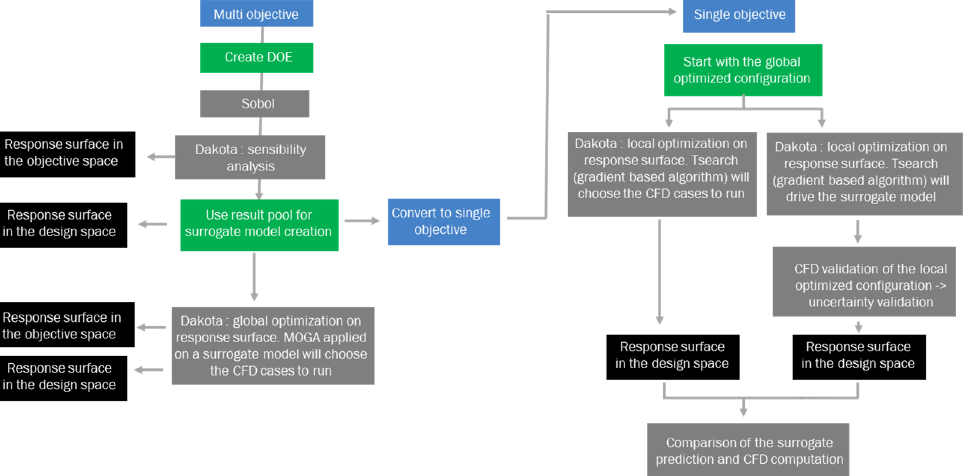
Figure 11. Different optimization methods used for drag reduction with ( left ) and without ( right ) pressure constraints.